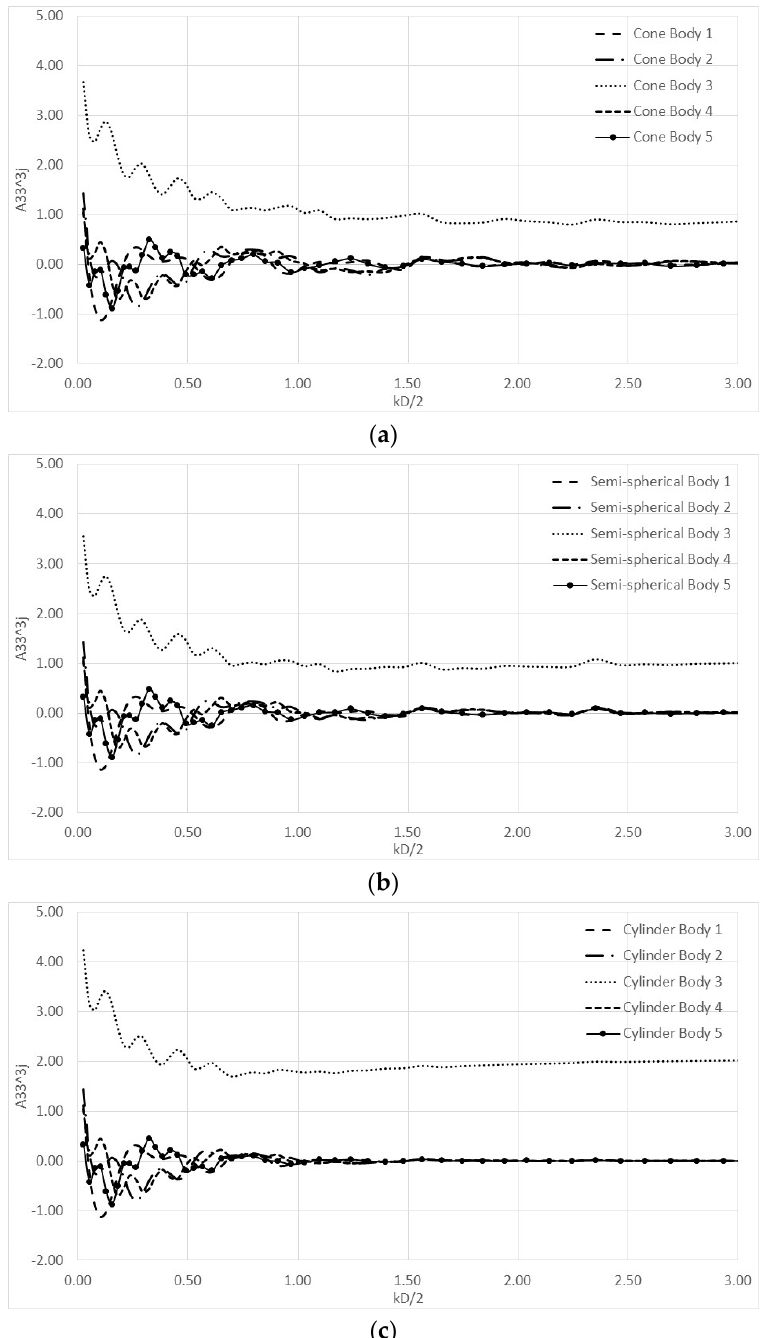
Figure 19. Dimensionless added mass of the 3rd floater in the heave direction due to the forced motion at heave of the j- th floater ( j = 1, 2, …, 5) against kD/2, for the three different examined types of floaters: ( a ) conical floater; ( b ) semi-spherical floater; ( c ) cylindrical floater in the perpendicular arrangement, C 3.